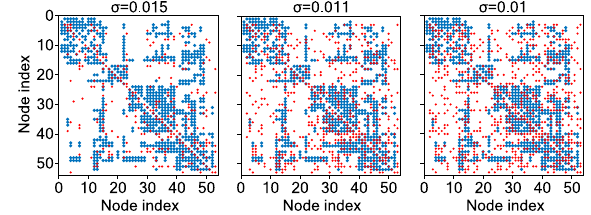
FIG. 2. Sparse recovery method on a cat cerebral cortex. Sparse recovery is applied to the data generated by bursting neurons electrically coupled on the cat cerebral cortex. Selecting the threshold parameter σ in the method changes the reconstructed network. Here we show the results of sparse recovery method for different enforced sparsity σ . The nonzero entries of the original network ’ s adjacency matrix are in blue. The red filled circles represent the nonzero entries in the adjacency matrix of the network reconstructed with the sparse recovery method. As each connection is small in comparison with the isolated dynamics, the sparse recovery tends to neglect